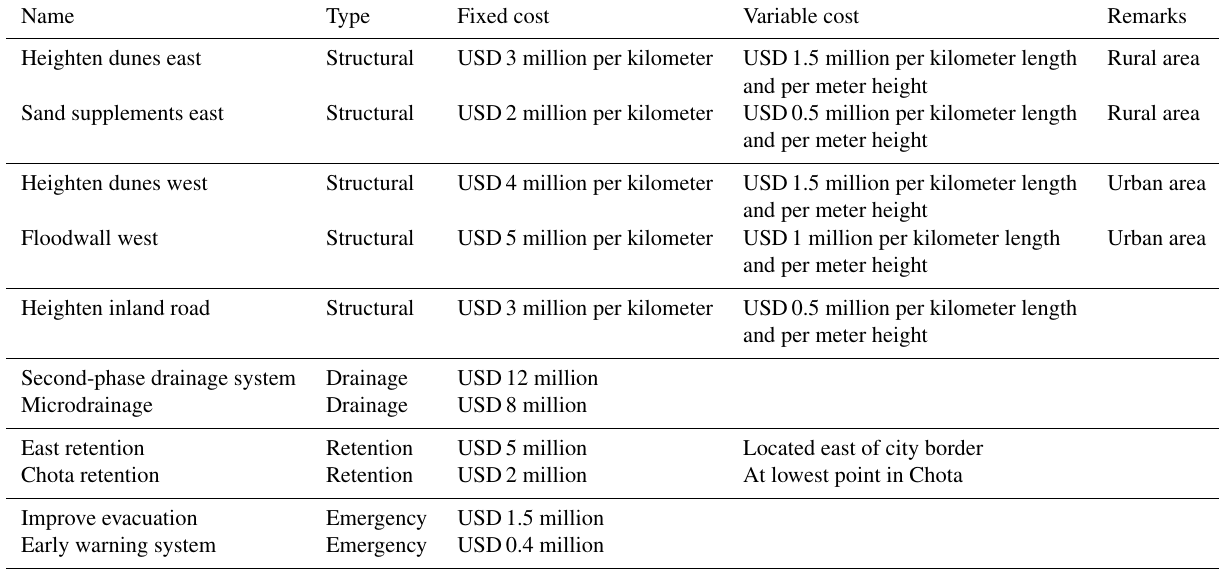
Table A1. Flood risk reduction measures used in the FLORES model for Beira, Mozambique. Cost estimates are based on local reference